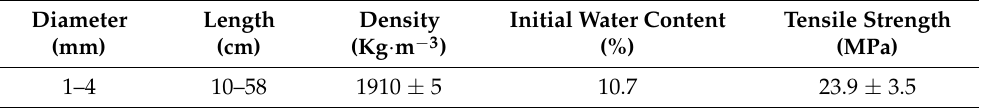
Table 1. Properties of Our Wheat Straw